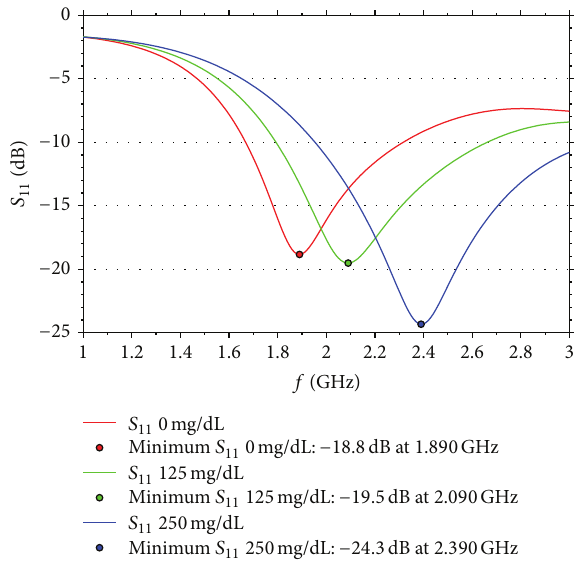
Figure 5: Computed 𝑆 11 of the sensor with container virtually filled with blood [11] with different glucose